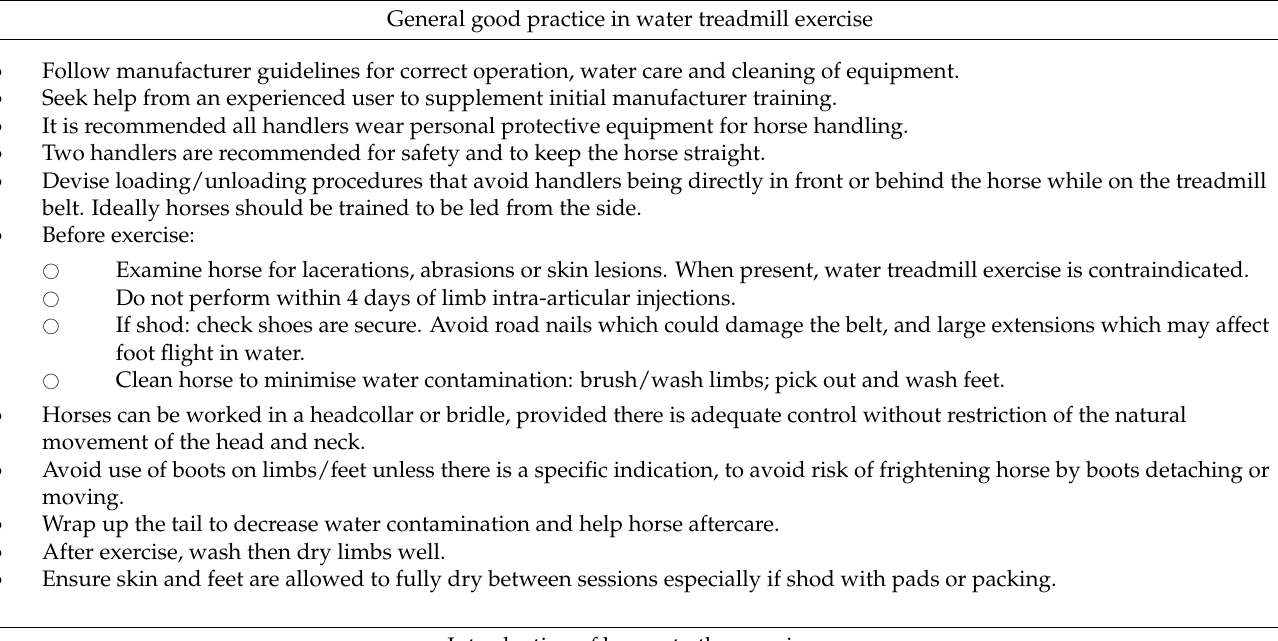
Table 1. Summary of guidelines for best practice in water treadmill